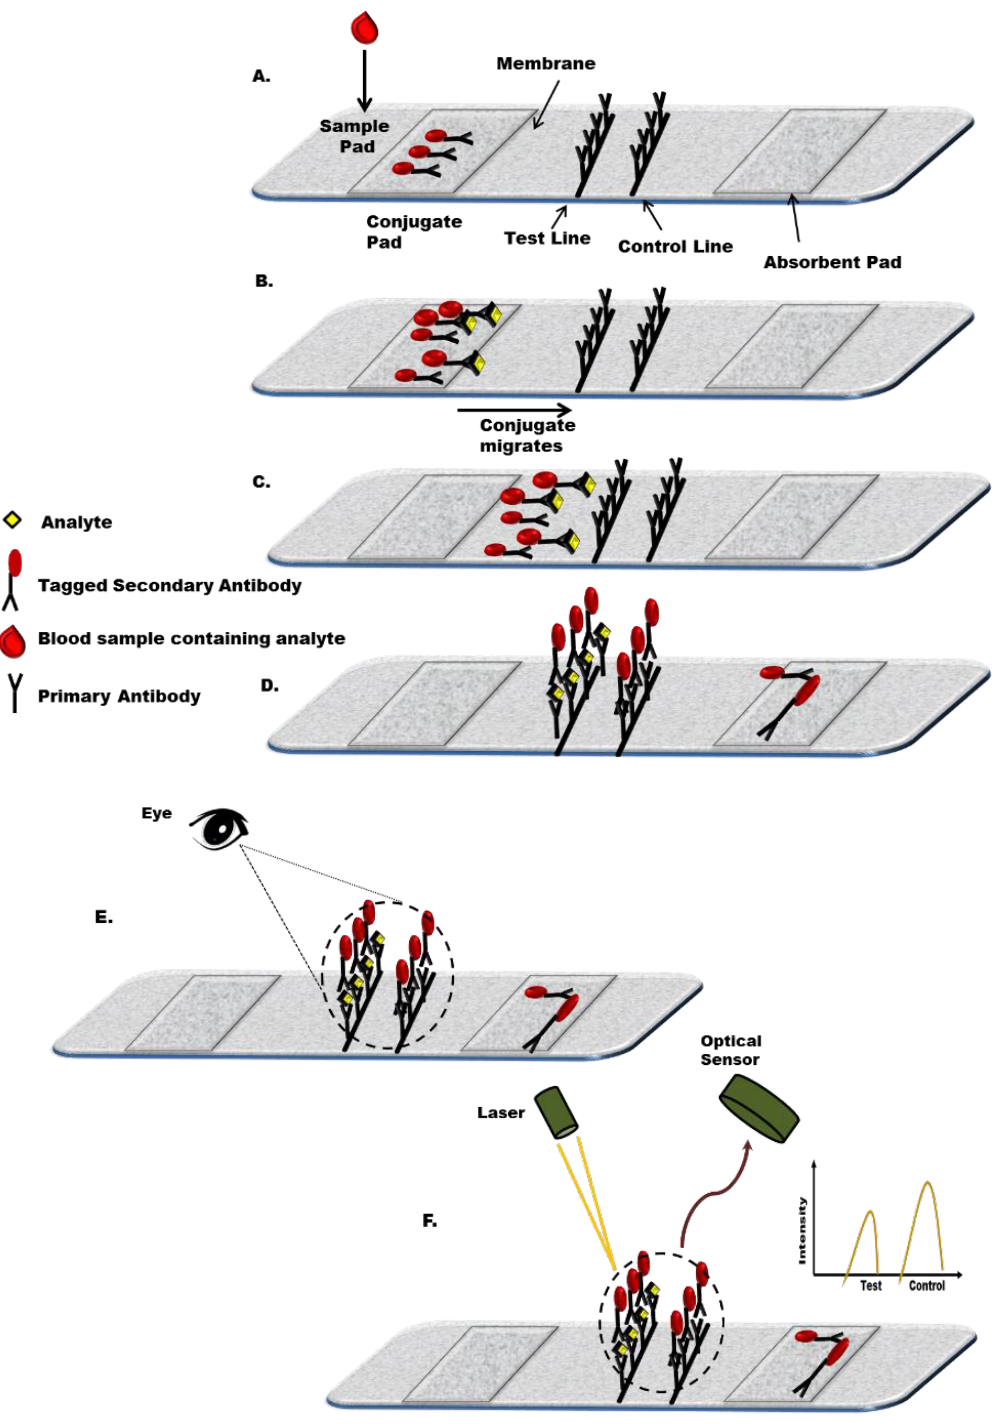
Figure 1. Schematic representation of the principle of sandwich format of a lateral flow immunoassay. ( A ) Labelled lateral flow test strip; ( B ) Migration of sample from sample pad to conjugate pad; if the desired antigen is present in the sample the conjugate will bind to it creating a complex (antigen-antibody-label); ( C ) The complex flows through the membrane towards the test line; ( D ) Immobilised Ab captures the complex and free labelled Ab and forms test and control lines, respectively; ( E ) Qualitative results-visual detection; ( F ) Quantitative detection, e.g., optical detection (depending on label